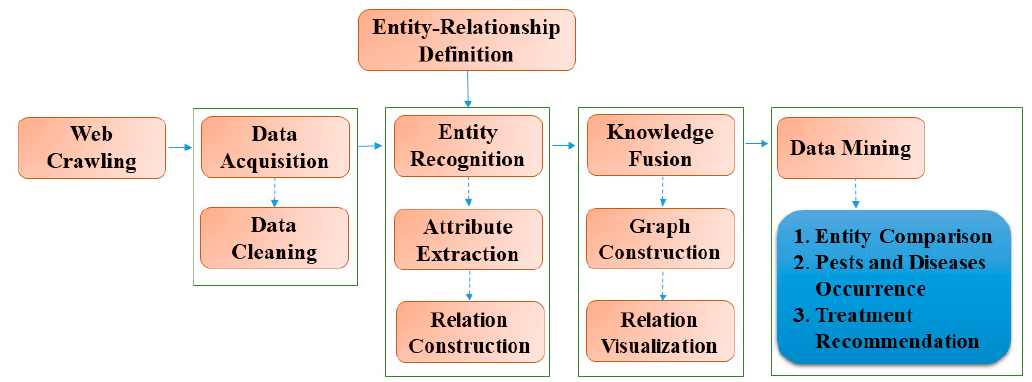
Figure 1. Framework of crop portrait construction.